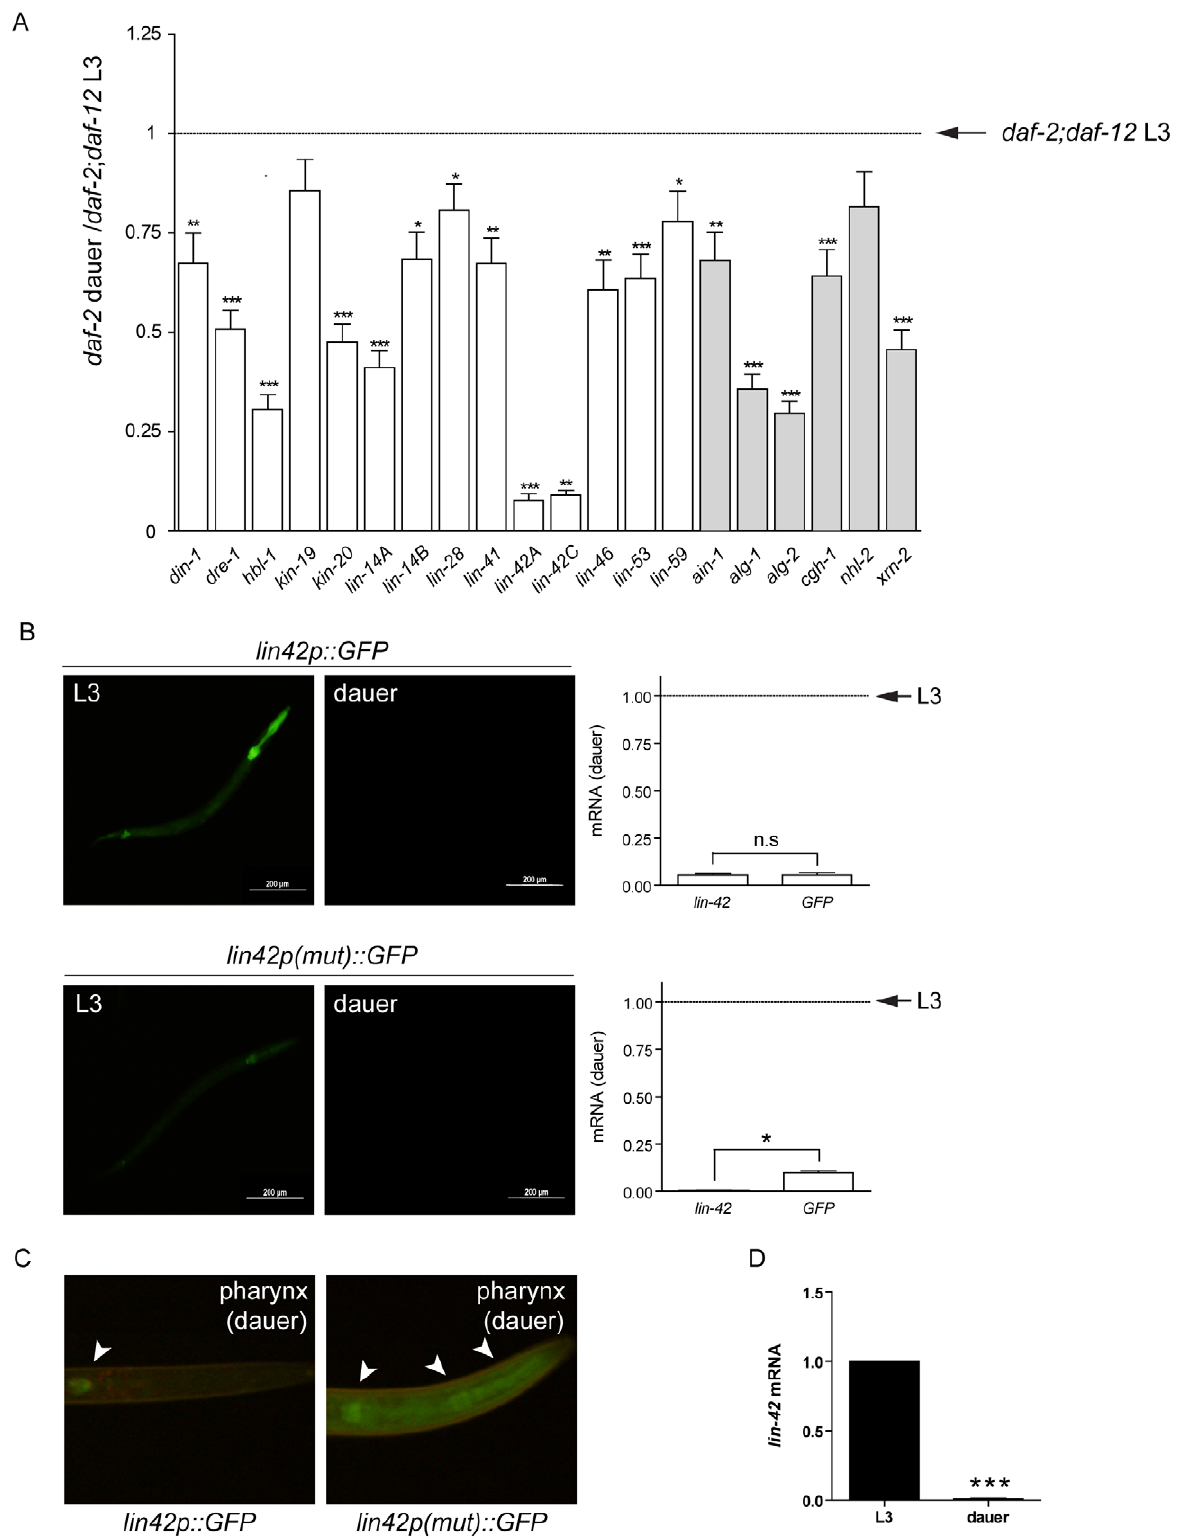
Figure 7. DAF-12 represses expression of target genes during dauer formation. ( A ) mRNA levels for heterochronic genes (white bars) or miRISC genes (grey bars) in L3 worms ( daf-2; daf-12(rh61rh411) ) or dauers ( daf-2 ) grown at 25 u C were quantified by NanoString analysis. The fold change for daf-2 dauer relative to L3 levels are shown ( B ) Images of lin-42p::GFP or lin-42p(mut)::GFP worms in L3 stage (left panels) or dauer stage (right panels). Expression of gfp or endogenous lin-42 in L3 and dauers stage worms as shown by RT-qPCR (graphs). ( C ) Detail of the pharynx from transgenic worms dauer arrested with increased exposure. Arrows indicate GFP expression. ( D ) Expression of endogenous lin-42 in L3 and dauer stage worms as shown by RT-qPCR. Bars denote standard error of mean (SEM). P-values were determined by Student’s t-test. * p , 0.05, ** p , 0.01, *** p , 0.001. doi:10.1371/journal.pgen.1002179.g007 PLoS Genetics |